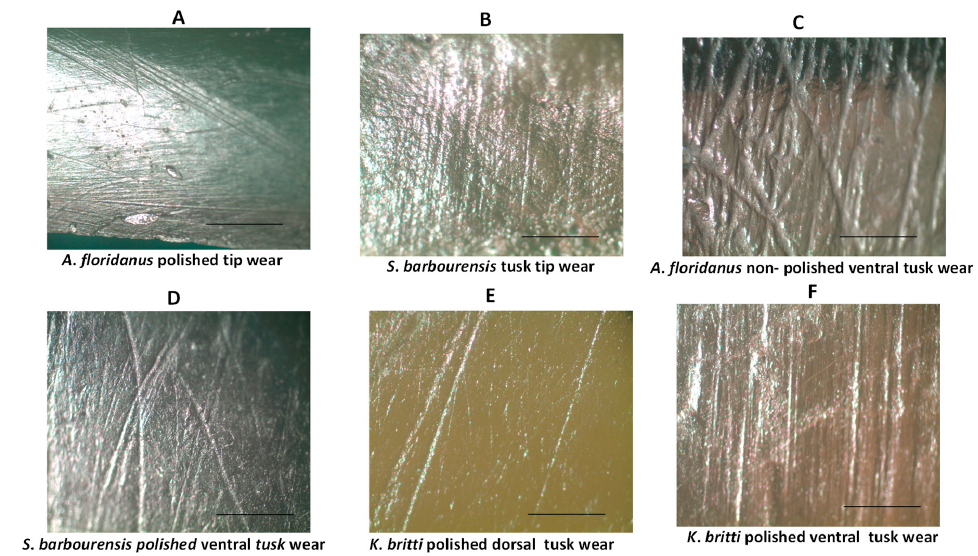
Figure 8. Examples of mandibular tusk wear scratch patterns. Enamel surface wear of shovel- tusker mandibular tusks. ( A ). Unusual mandibular tusk tip facet with randomly arranged scratches ( A . floridianus, UF 217471); ( B ). A . floridianus (UF 212304) ventral mandibular tusk wear (non-polished); ( C ). S . barbourensis ventral mandibular tusk wear on wear facet (UF 39050); ( D ). S . barbourensis mandibular tusk tip wear (UF 97269; ( E ). K . britti dorsal mandibular tusk wear (UF 97269); ( F ). K . britti ventral mandibular tusk (UF 97269). Scale bar = 0.4 mm; magnification—( A ). = 10 × ; ( B – K ) = 35 × . Table 5. Mandibular tusk wear results for A . floridanus , K. britti and S . barbourensis